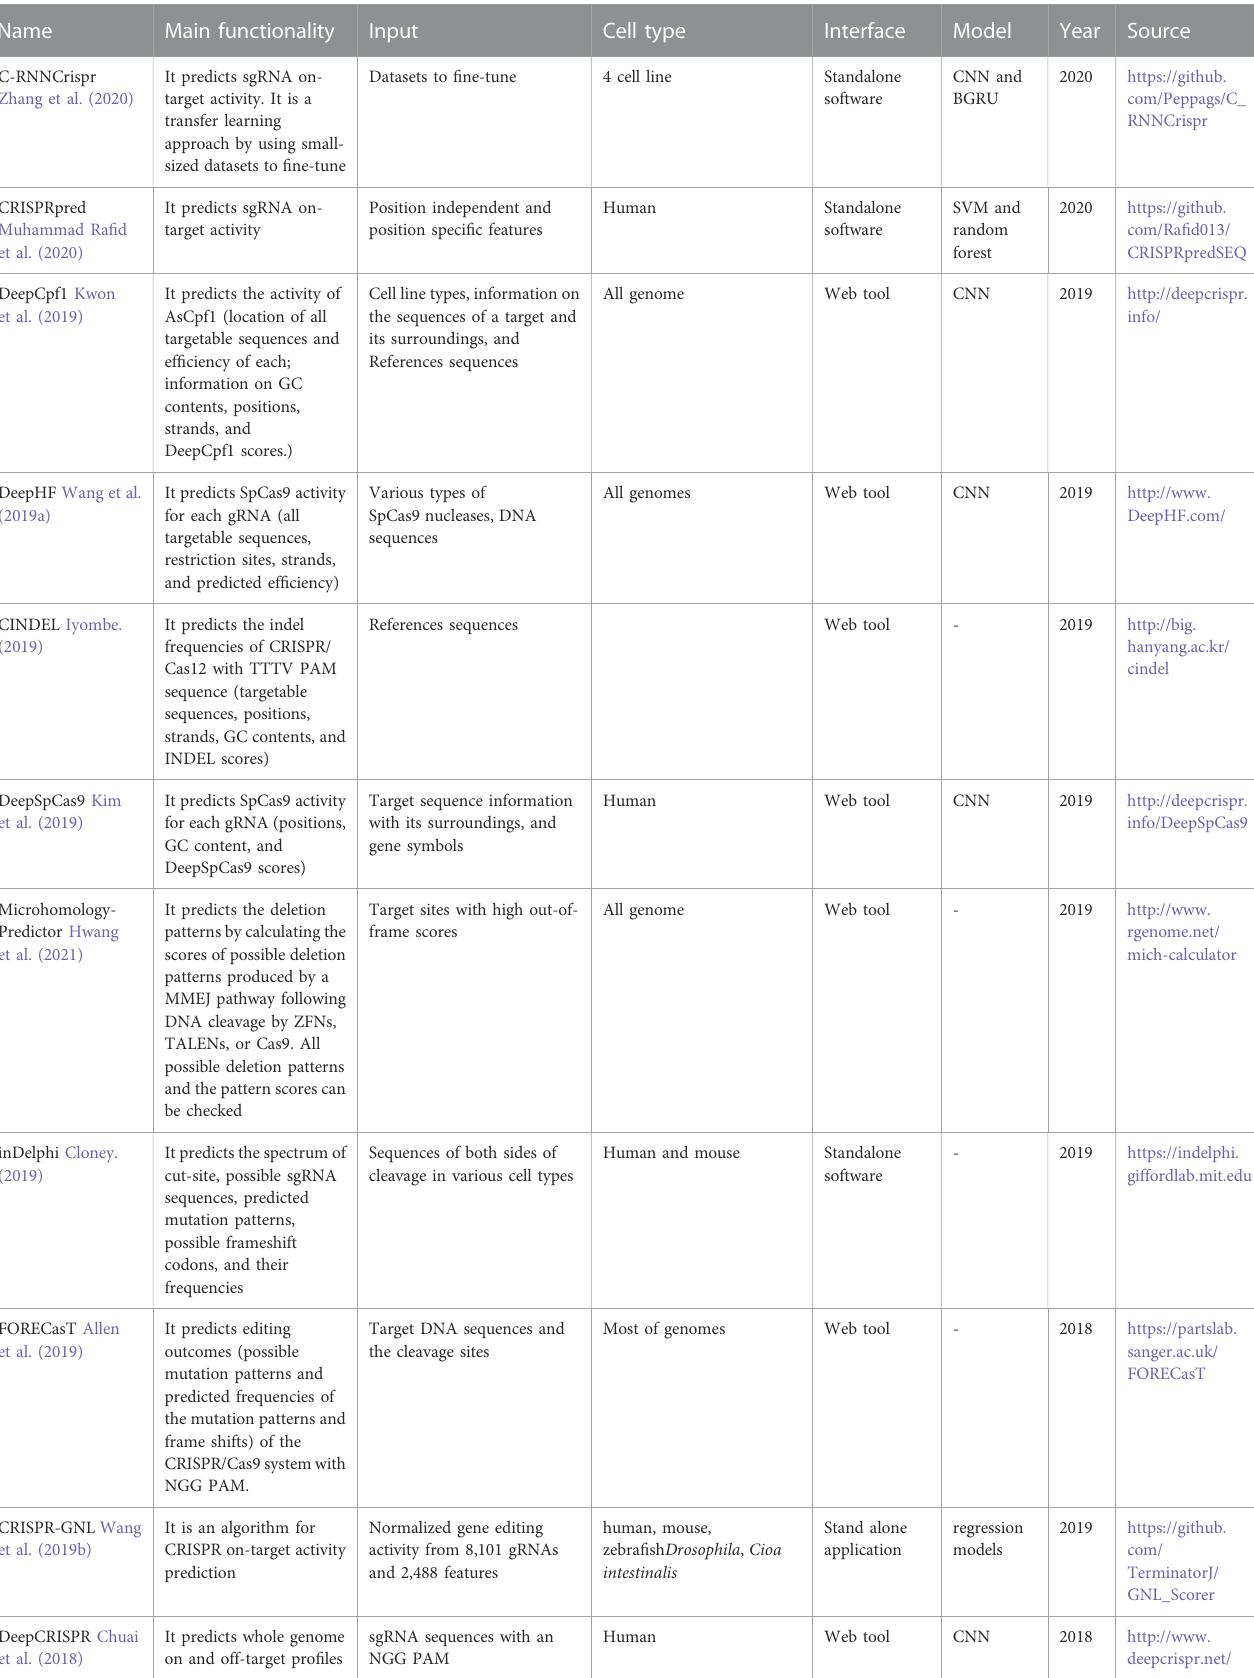
TABLE 4 MDL-based tools and software packages related to CRISPR